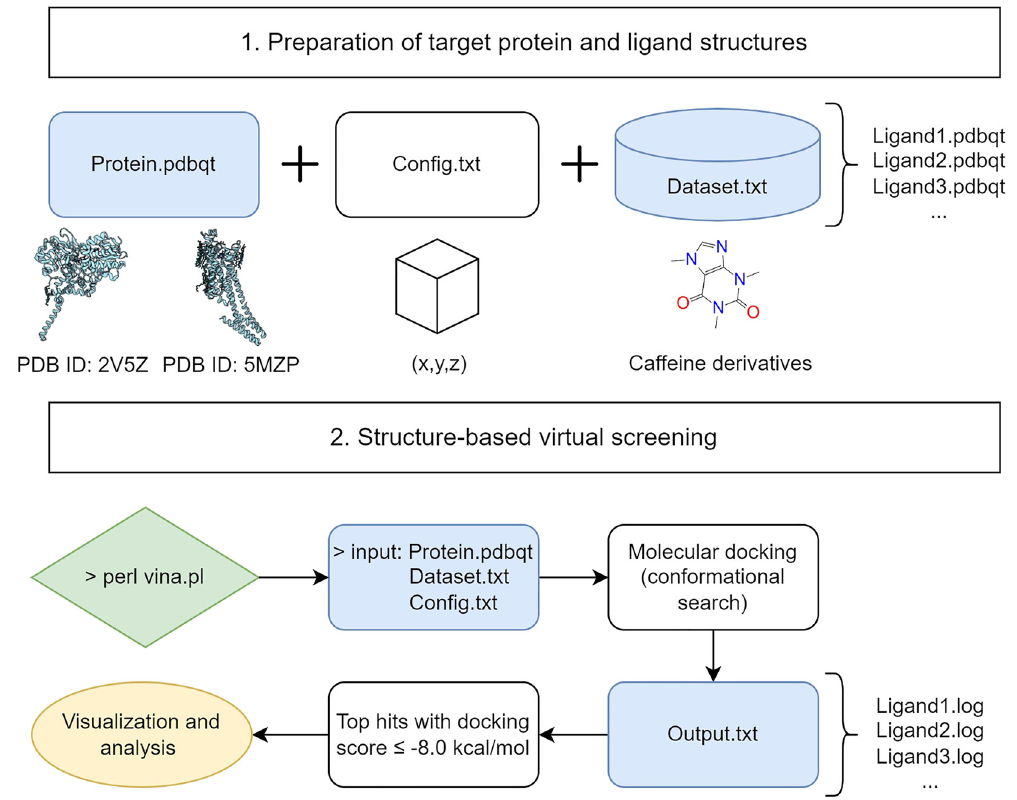
Figure 3: Proposed workflow for structure-based virtual screening using AutoDock